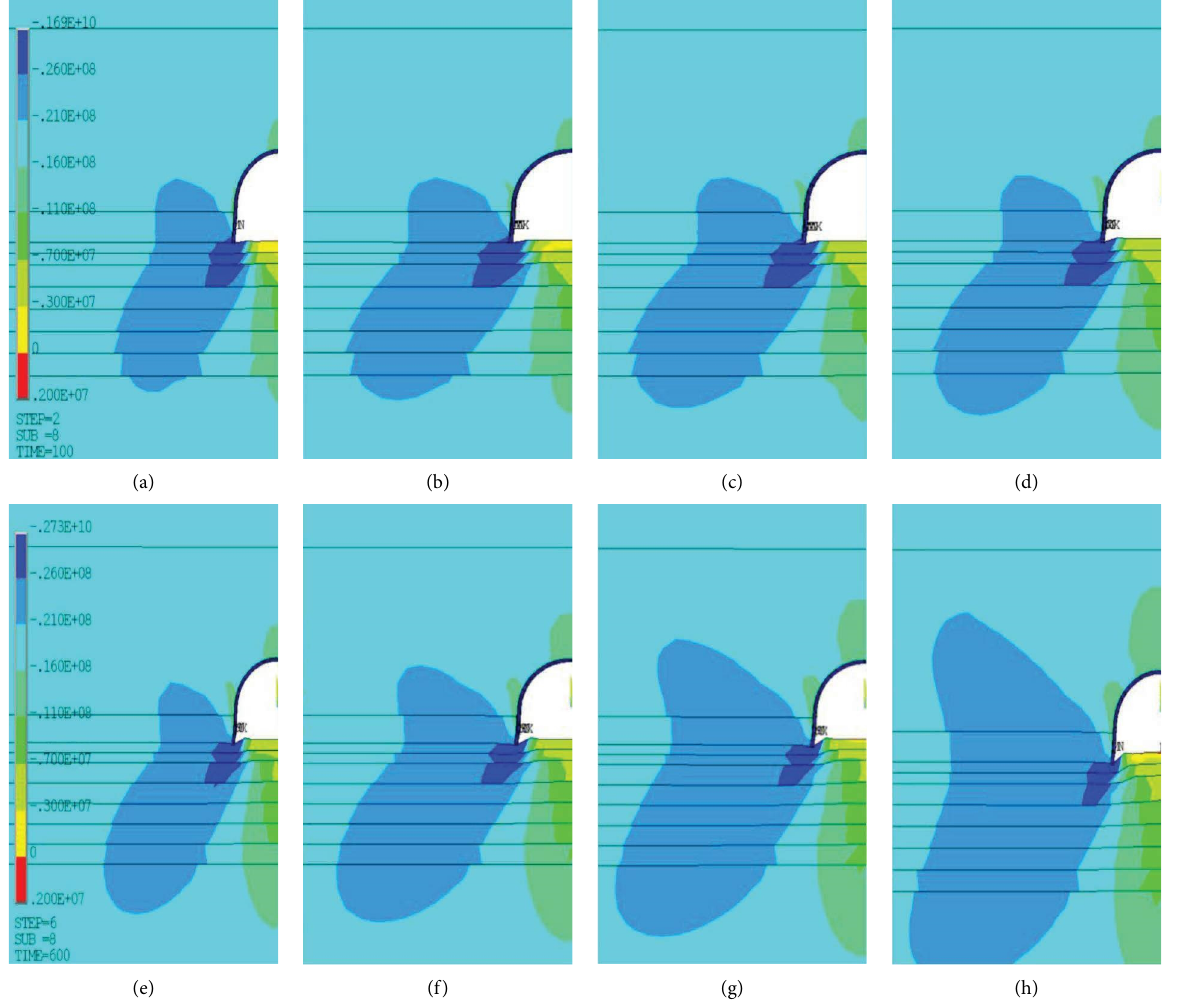
Figure 7: Minimum principle stress ( σ 3 ) distribution around the roadway with a step-by-step increase in rock fracturing: (a) step 2; (b) step 3; (c) step 4; (d) step 5; (e) step 6; (f) step 7; (g) step 8; (h) step